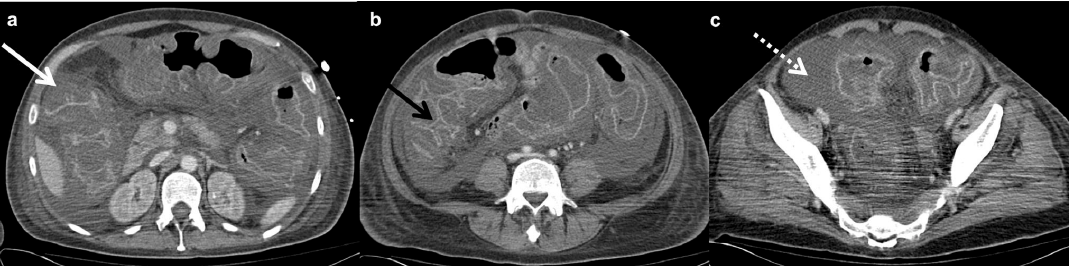
Figure 1. CT imaging used to identify C. diff. with an axial CT scan demonstrates low-attenuation wall thickening involving the entire length of the colon with intense mucosal enhancement (white arrow, ( a )); the enhancing mucosa is stretched over the edematous haustral folds, resembling an accordion even in the absence of intra-luminal contrast (black arrow, ( b )). A large amount of ascites is also present (dashed arrow, ( c ))